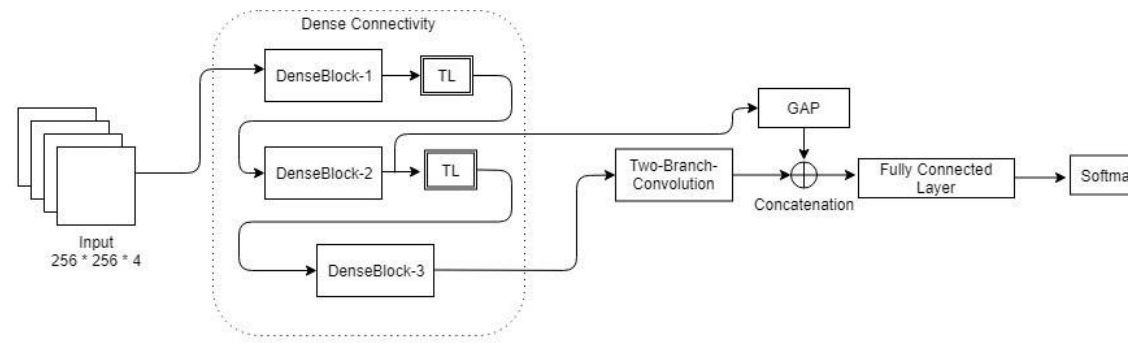
Figure 1. The architecture of DenseLuNet-2. TL: Transition layer, DenseBlock: cf. Fig. 2, Two-Branch-Convolution: cf. Yang